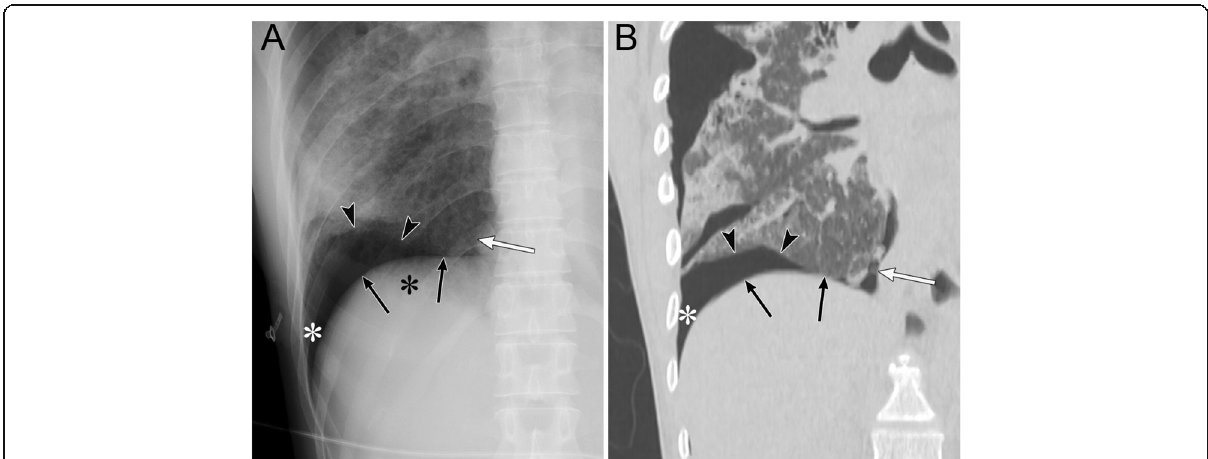
Fig. 4 Pneumothorax in the subpulmonary space of a 36-year-old woman with interstitial pneumonia. a A supine radiograph shows a hyperlucent upper quadrant of the abdomen (black asterisk). The inferior surface of the lung (arrowheads), a sharply outlined diaphragm (black arrows), the sharp delineation of the inferior vena cava (IVC) (white arrow), and the “ deep sulcus ” sign (white asterisk) are also visible. b A coronal CT image clearly depicts the inferior surface of the lung (arrowheads) , a sharply outlined diaphragm (black arrows), the sharp delineation of the IVC, and the “ deep sulcus ” sign (white asterisk)